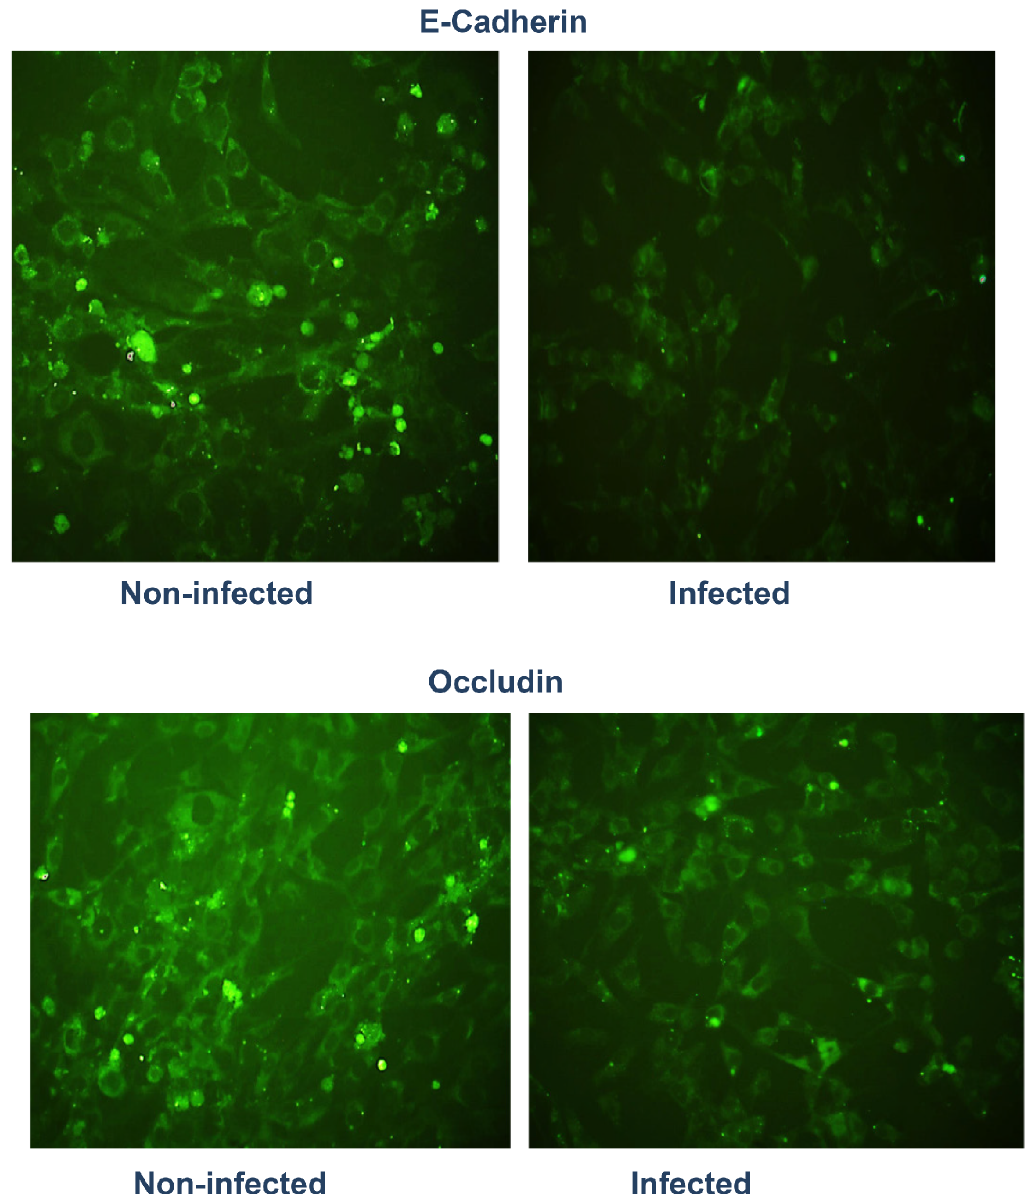
Fig 3. Chlamydia infection of reproductive epithelial cells induces epithelial-mesenchyme transition (EMT) (Loss of epithelial markers). Monolayers of murine oviduct epithelial cells were infected with C . trachomatis L and after 72h immunofluorescence staining of the cells for epithelial markers was performed on infected and non-infected monolayers by standard procedures. Fluoresceinated antibodies against the following markers were used: E — cadherin and occlusin. Antibodies stained both intracellular and surface antigens. Images were acquired at 20X objective on a Nikon fluorescent microscope with the same microscope settings and exposure time. The representative slides are from several repeated experiments showing identical